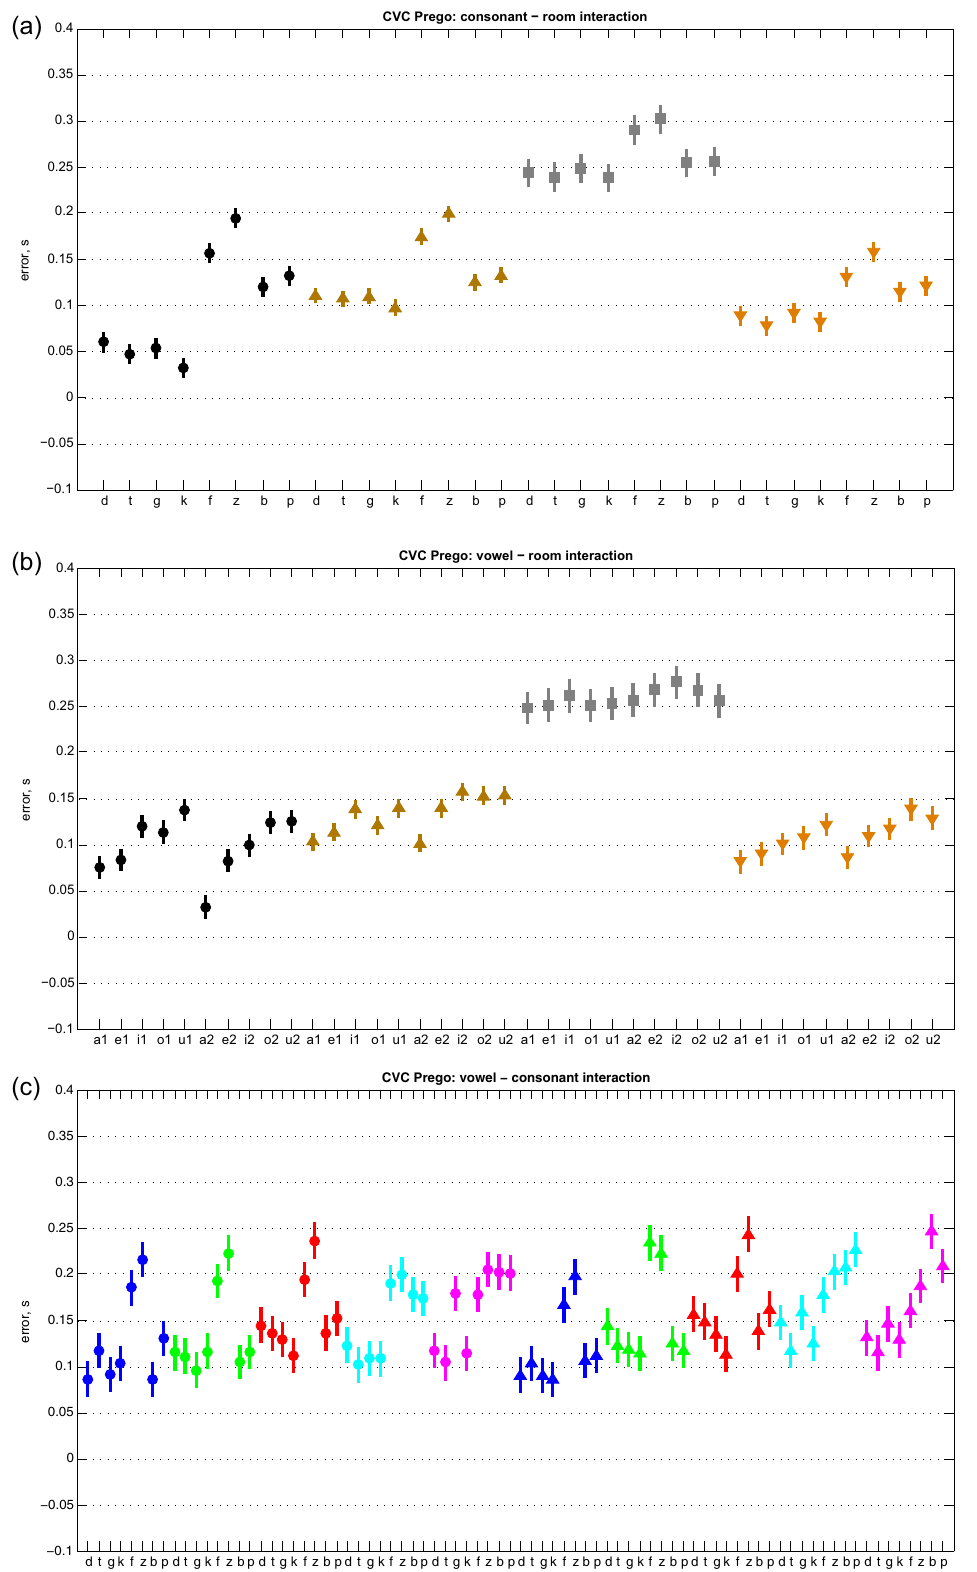
Figure 2. CVC logatomes: marginal means for Prego ’ s algorithm. (a) “ Consonant ” (cid:5) “ room ” interaction, (b) “ vowel ” (cid:5) “ room ” interaction, (c) “ vowel ” (cid:5) “ consonant ” interaction. For more details see Figure